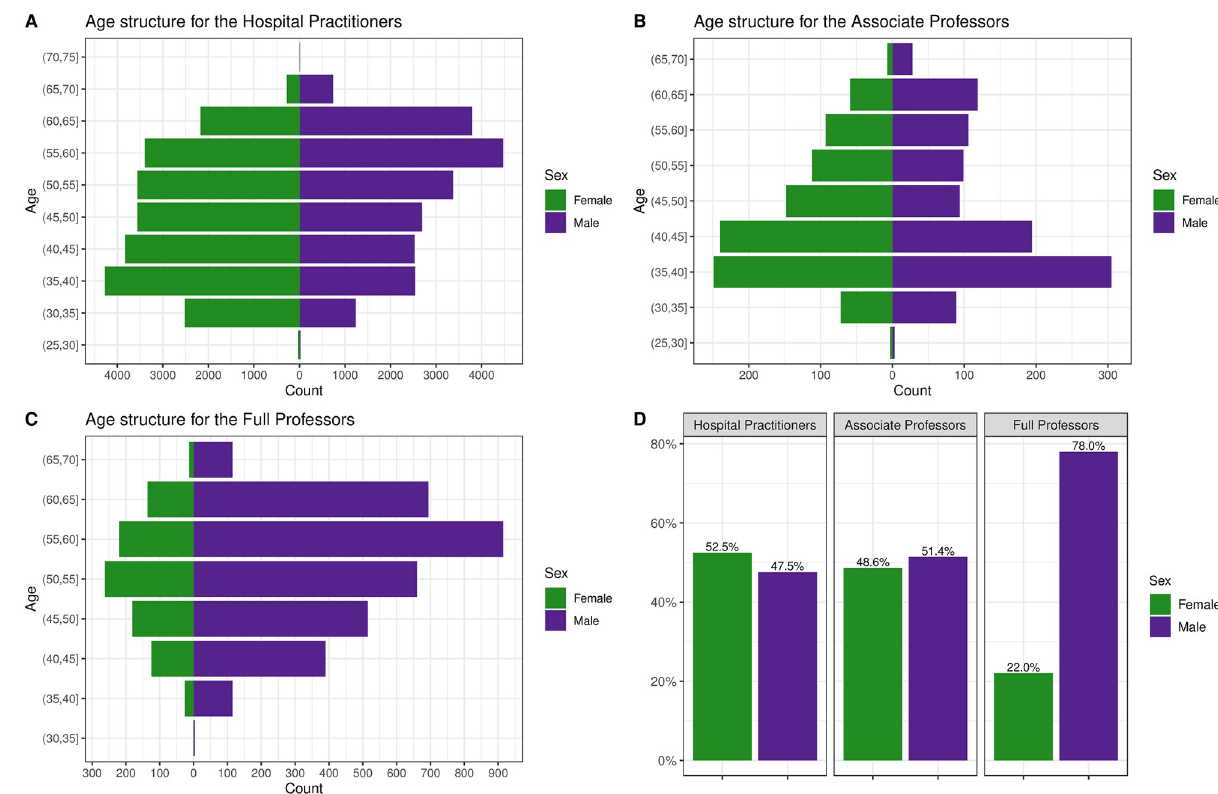
Fig 1. Age structure of Hospital Practitioners (A), Associate Professors (B), Full Professors (C), and gender distribution of all (D) in 2020.